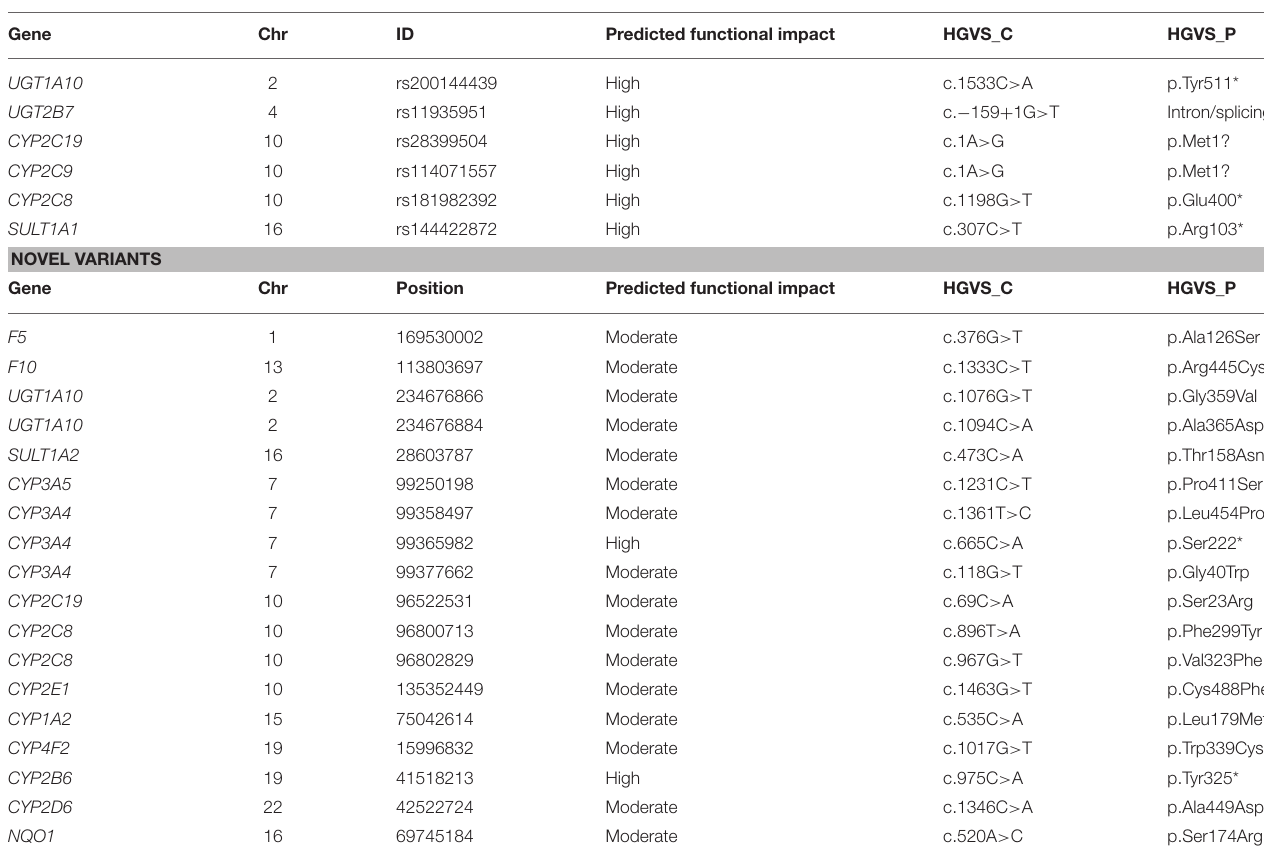
TABLE 3 | Novel and known variants on relevant pharmacogenes at MAF > 5%.